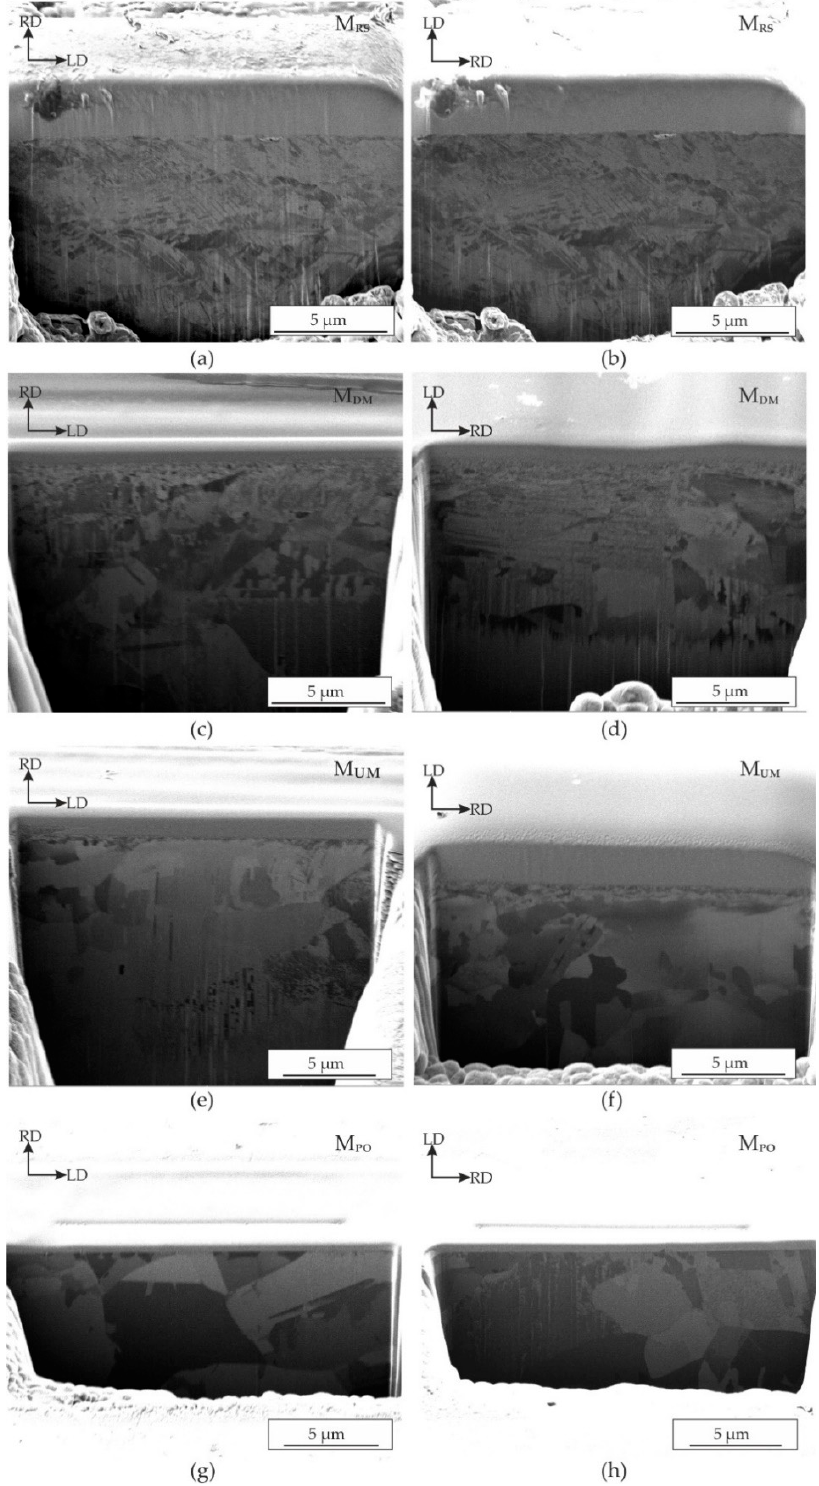
Figure 5. Focused Ion Beam (FIB) images of the investigated surface morphologies transverse and longitudinal to loading direction (LD) and rolling direction (RD): ( a ) M RS longitudinal to loading direction; ( b ) M RS transverse to loading direction; ( c ) M DM longitudinal to loading direction; ( d ) M DM transverse to rolling direction; ( e ) M UM longitudinal to rolling direction; ( f ) M DM transverse to rolling direction; ( g ) M PO longitudinal to rolling direction; ( h ) M PO transverse to rolling